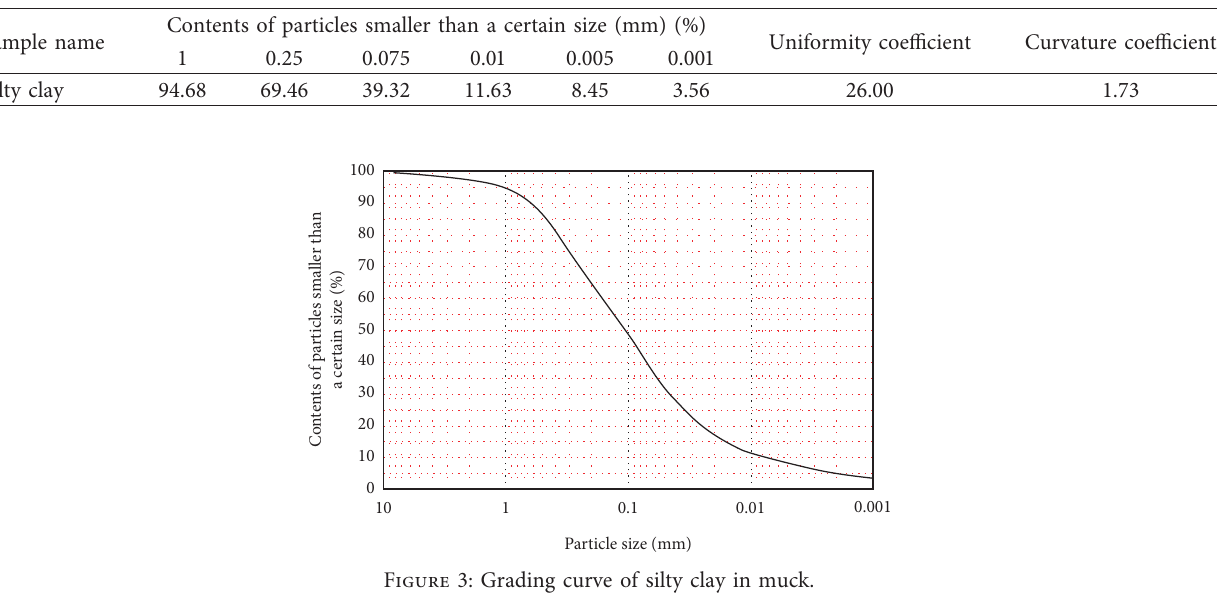
Table 2: Particle size composition of silty clay in muck.